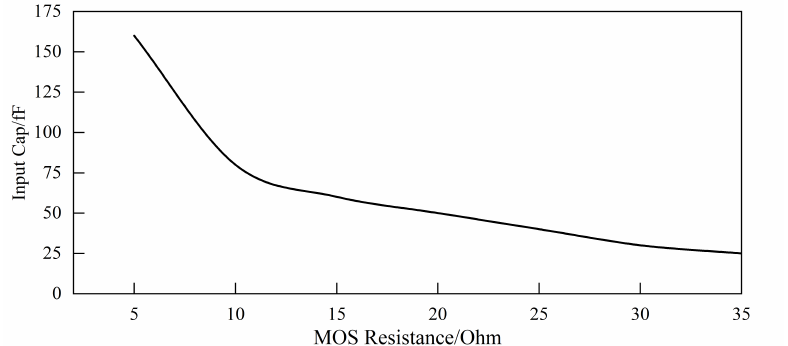
Figure 13. Relation between MOS resistance and capacitance.